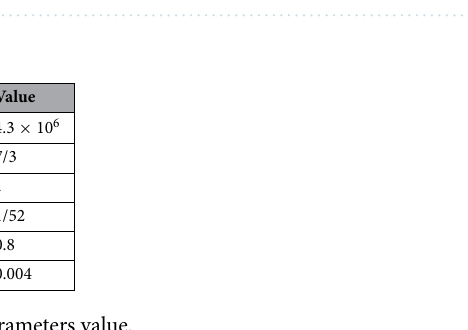
Figure 4. Sentinel hospitals data in the first quarter of 2013 and fitting data by using least-square are showed. The minimum (maximum) degree is 5 (500) and the mean degree is 7.5.